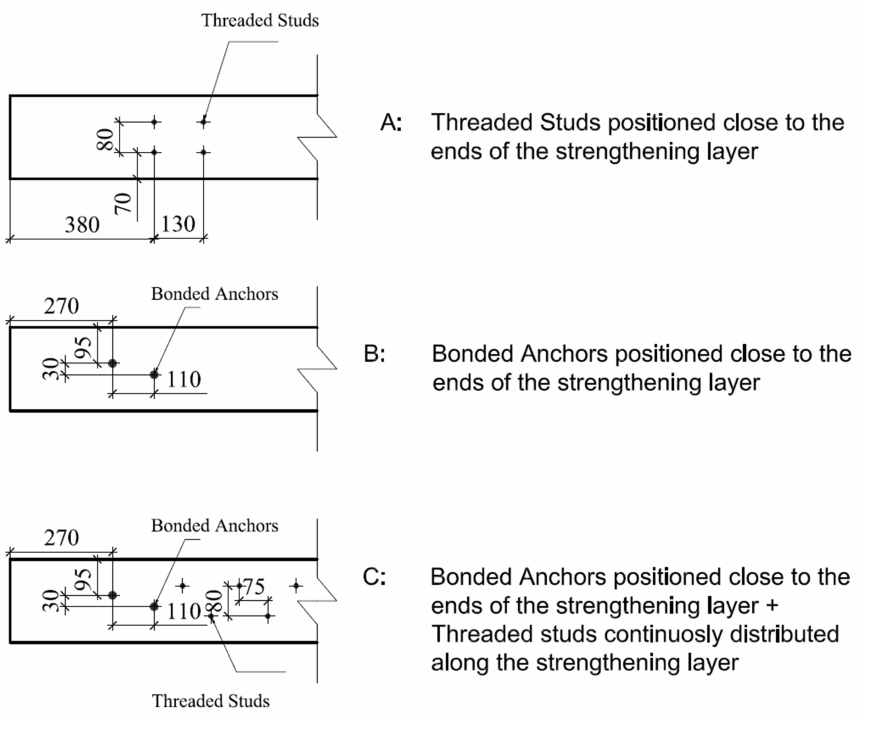
Figure 2. Geometrical layout of the mechanical anchorages. Table 1. Strengthening solutions and characteristics of the cementitious materials.